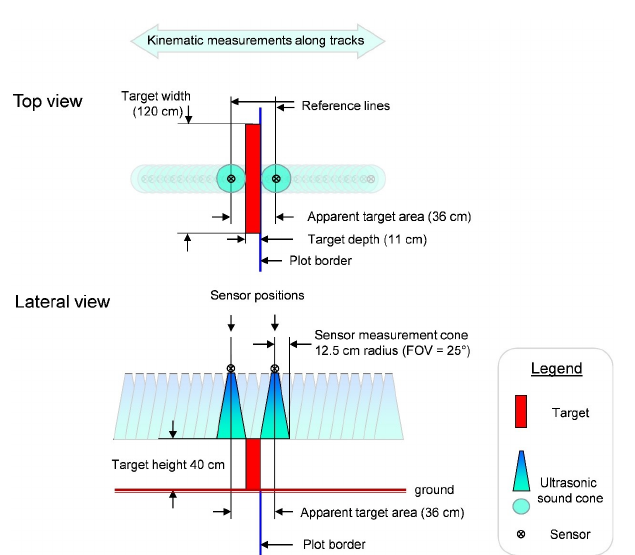
Figure B2. Display of a reference target, as used for assessing po- sition accuracy and measured by ultrasonic sensors during passage of the vehicle. The two featured sensor positions show the distance range of expected target detection (apparent target area) indepen- dent of moving direction. These positions are used as reference lines for distinction and classification of correct and erroneous measure-